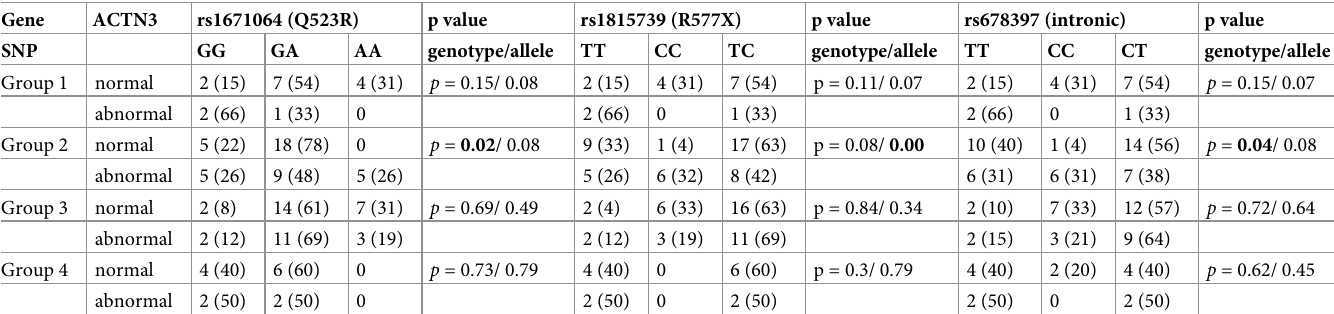
Table 4. Comparison of SNP genotypes by condyle modeling pattern.